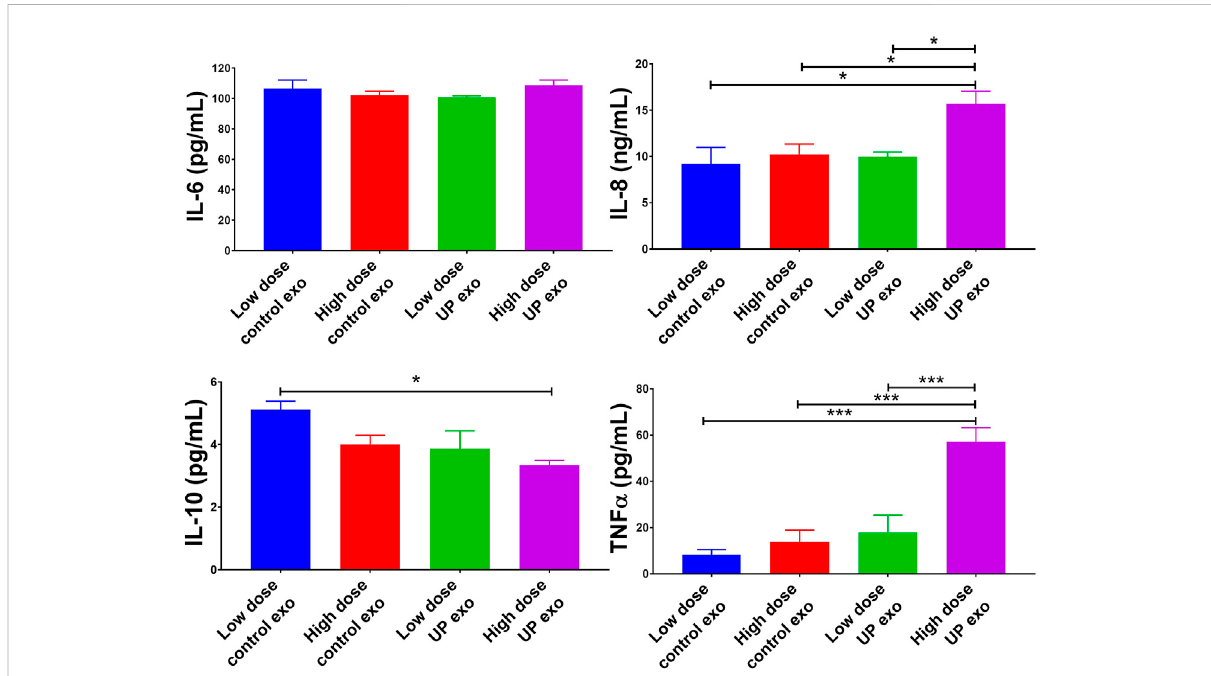
FIGURE 5 Exosomes from ECTO cells infected with U. parvum promote pro-in fl ammatory responses in human macrophages. Pro-in fl ammatory cytokineshumanIL-6,IL-8,andTNF α ,andanti-in fl ammatorycytokineIL-10levelsinculturemedium collectedfromTHP-1macrophagesafter24 h treatment with exosomes from uninfected vs. U. parvum- infected ECTO cells. Error bars represent mean concentration ± SEM, n = 5 technical